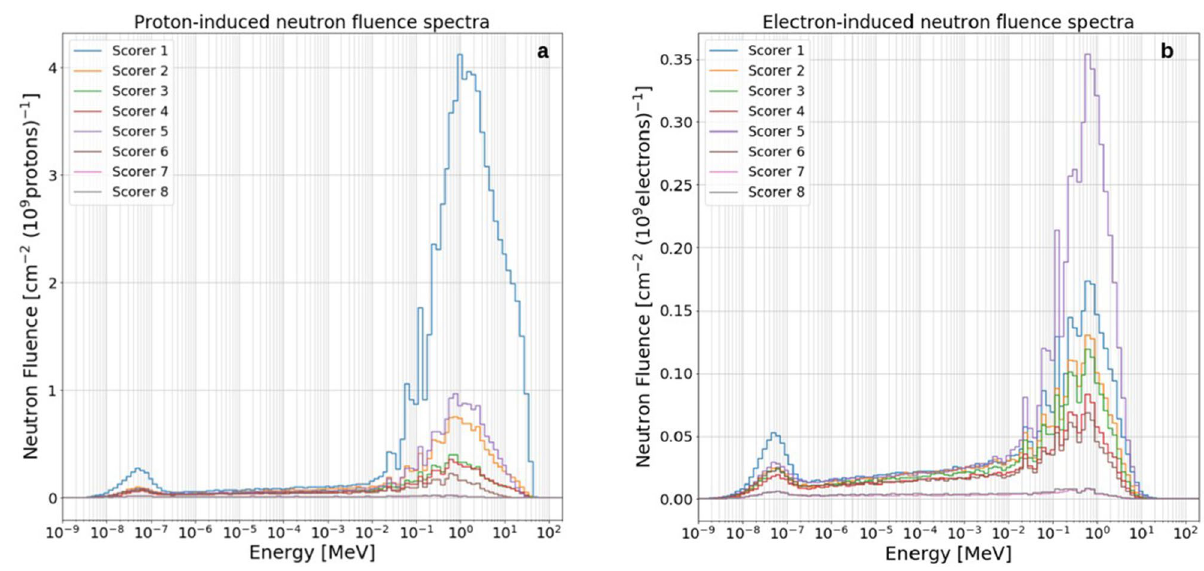
Figure 8. Proton- ( a ) and electron-induced ( b ) neutron fluence spectra for all scorers inside the LION cave (see Fig. 2) using Ma2019 input parameters. Values are normalized to 10 9 primary